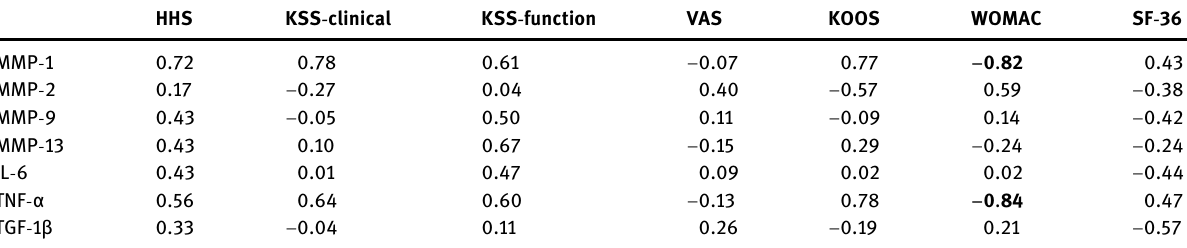
Table 3: Pearson ’ s correlation between the investigated proteins and the clinical scores HHS KSS - clinical KSS - function VAS